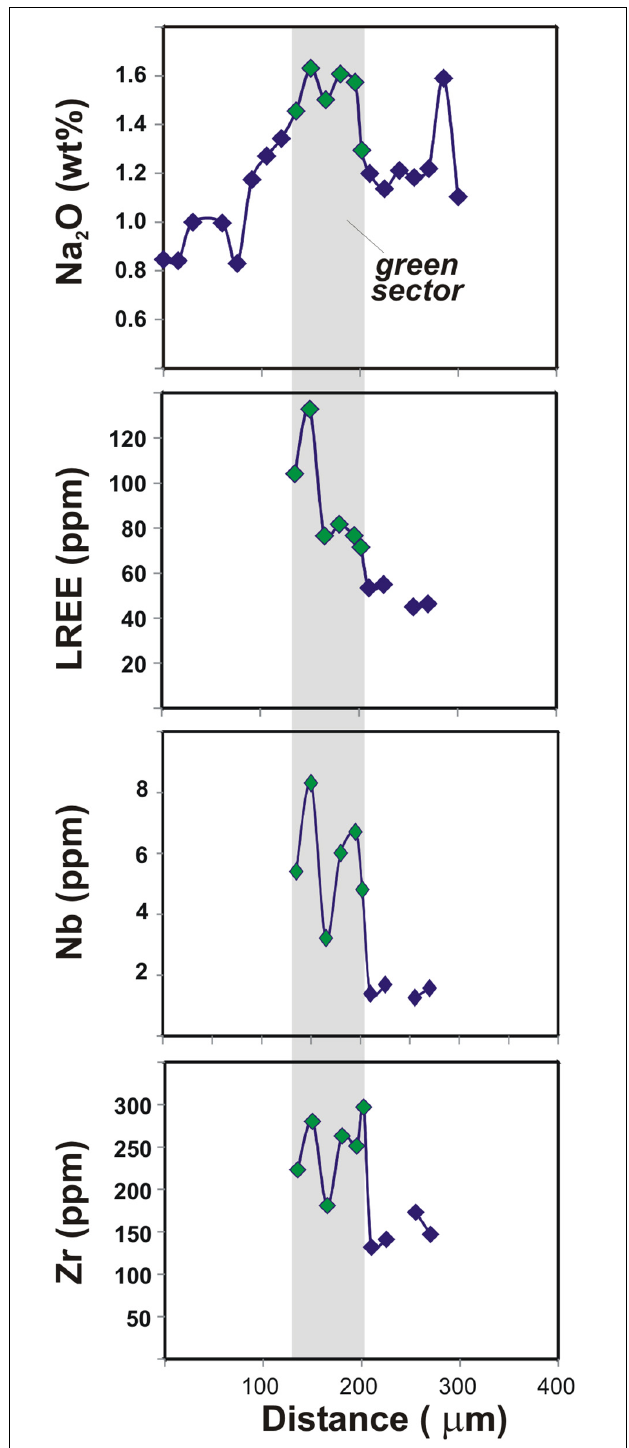
FIGURE 9 | Chemical profiles showing compositional variations in a greenish-to-colorless zoned clinopyroxene crystal of pyroxenite 115601. The Na 2 O vs. distance plot is taken from Villaseca et al. (2019a). Green clinopyroxene area is marked, and laser spots are depicted in Figure 1D of this work. Note the high Na 2 O, REE and HFSE contents in the green bands relative to the surrounding (colorless)